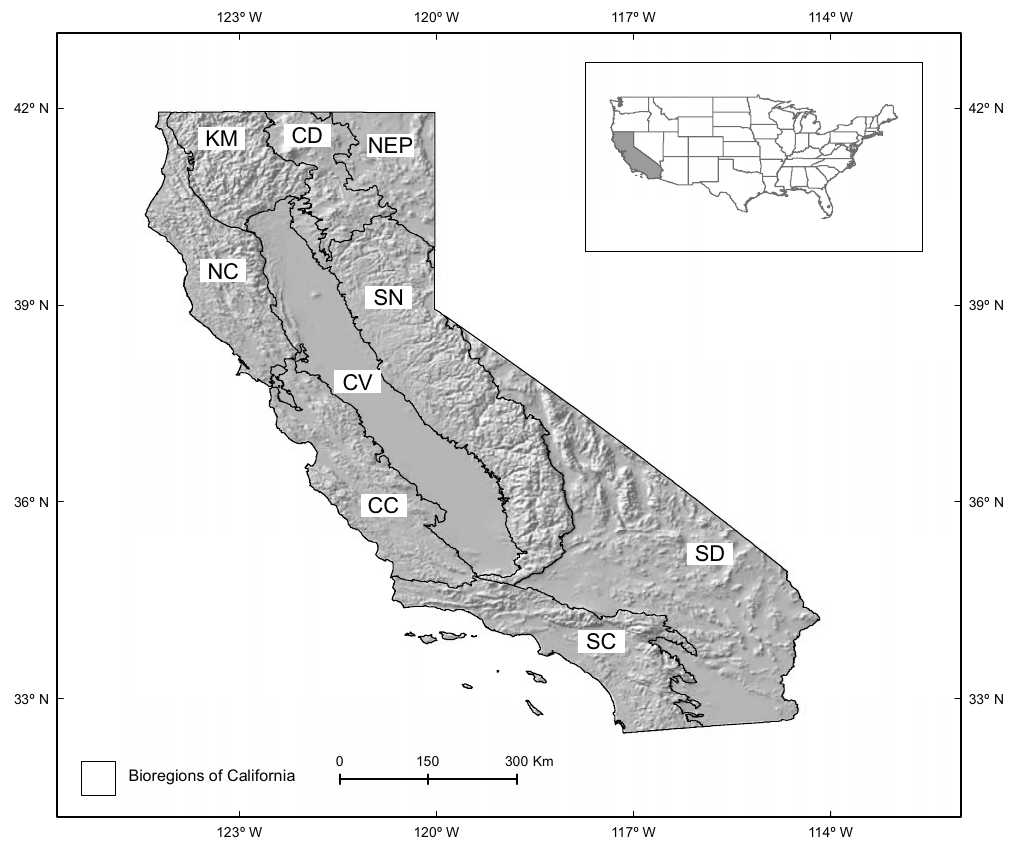
Figure 1. Shaded relief map of the California bioregions as defined by Sugihara et al. [2]. Delineation of the bioregions is based on common patterns of vegetation, topography, landforms and the ecological role of fire. North Coast (NC), Central Coast (CC), South Coast (SC), Klamath Mountains (KM), Southern Cascades (CD), Northeastern Plateau (NEP), Sierra Nevada (SN), Central Valley (CV) and Southeastern Deserts